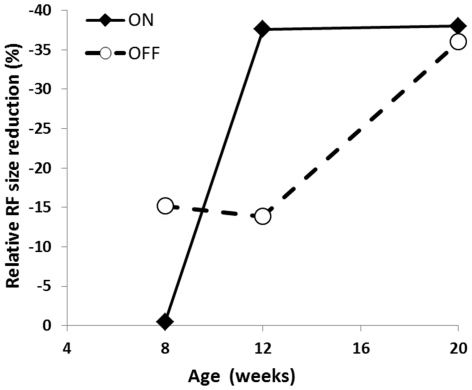
Receptive field size reduction in ON- and OFF-RGCs.The abscissa is animal age (wk) and vertical coordinate depicts relative percentage of RF size reduction. Filled diamond and solid line represents ON-RGC while open circle and dashed line shows OFF-RGC RF size reduction.